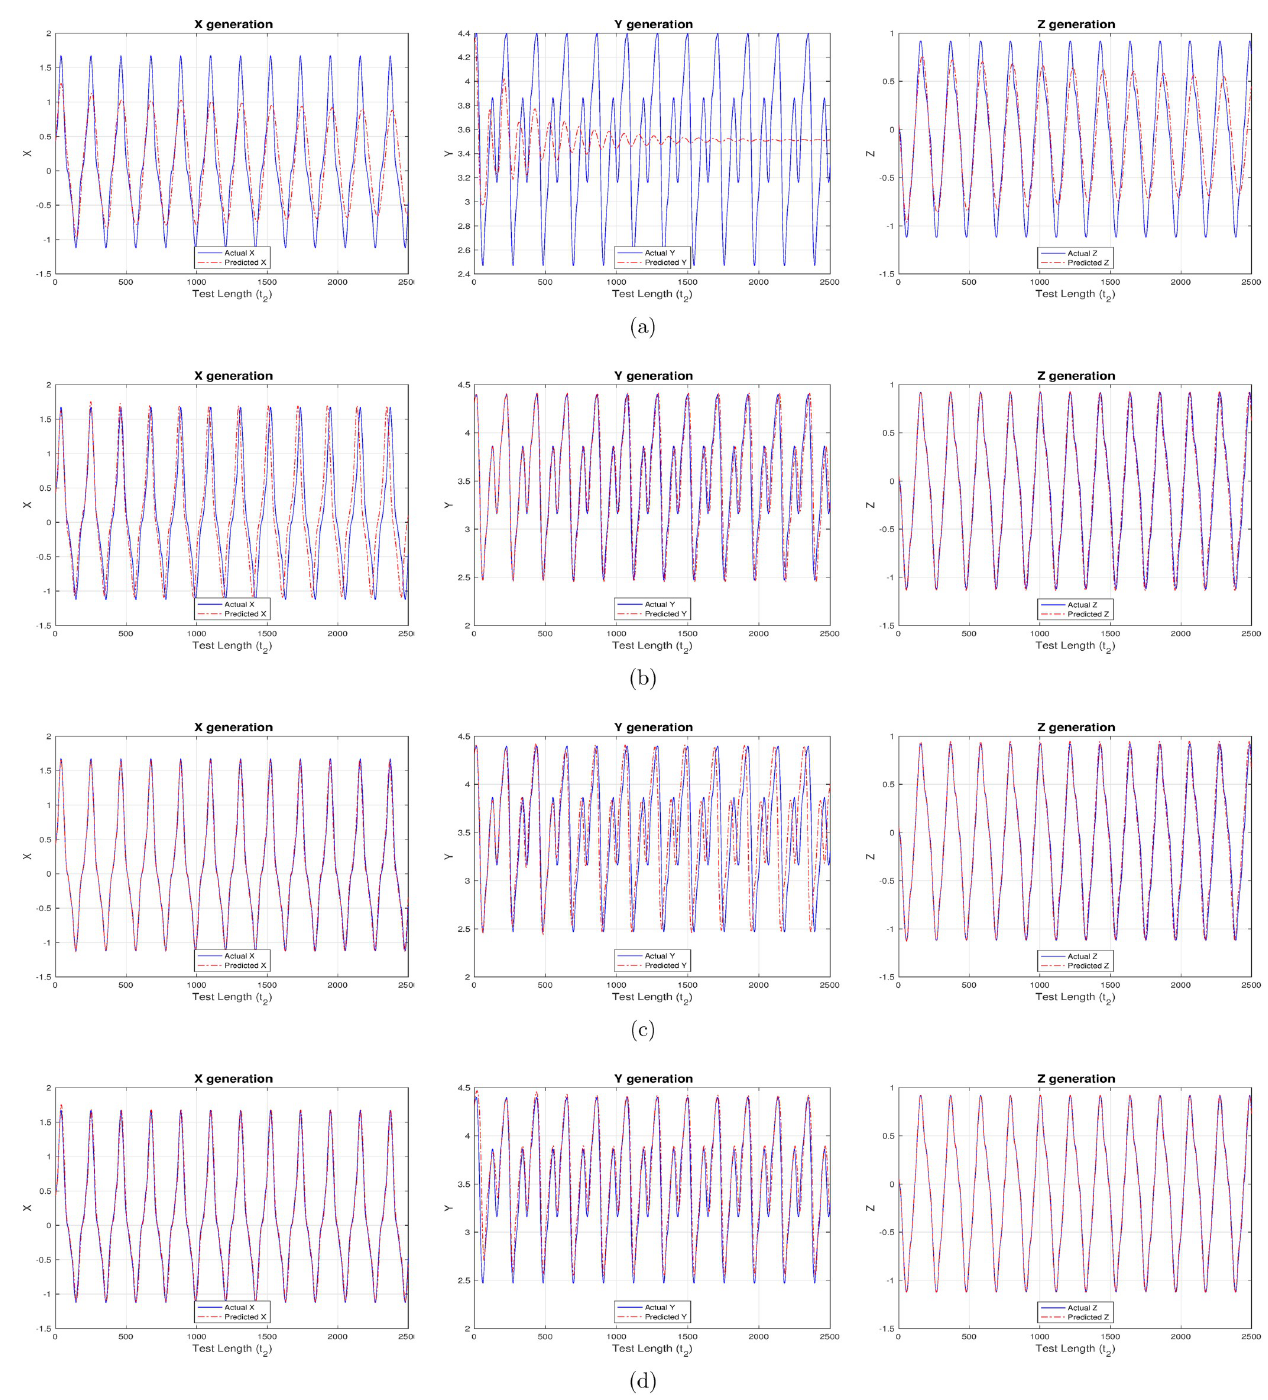
Fig 3. Predicting the controlled (time-delayed feedback) financial system behavior using different activation functions. (a) linear activation (b) strictly non-linear activation (c) quadratic activation (d) tanh activation.